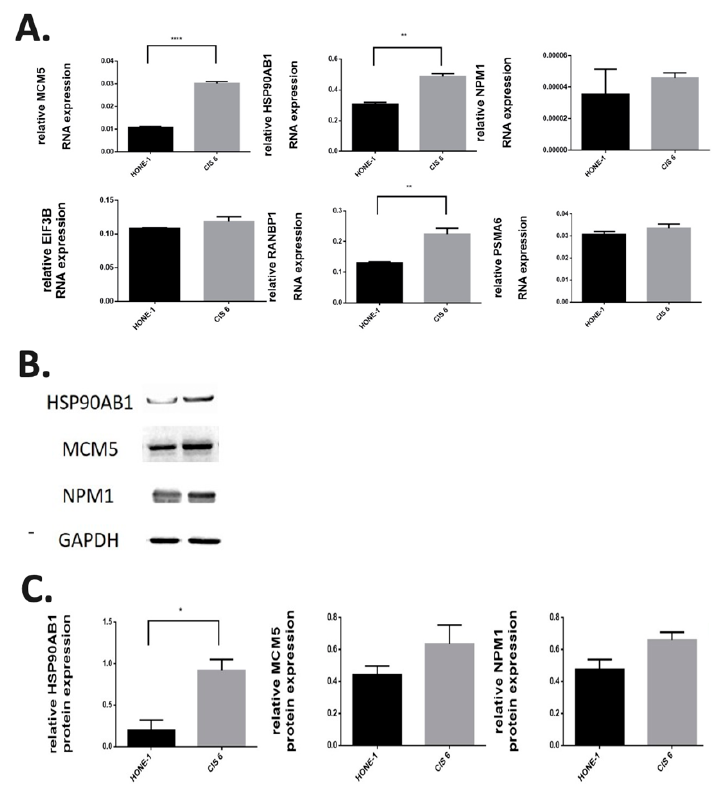
Figure 4. RNA and protein expression in cisplatin-resistant nasopharyngeal carcinoma cell lines. ( A ) Expression of MCM5, HSP90AB1, NPM1, EIF3B, RANBP1, and PSMA6 RNA analyzed through real-